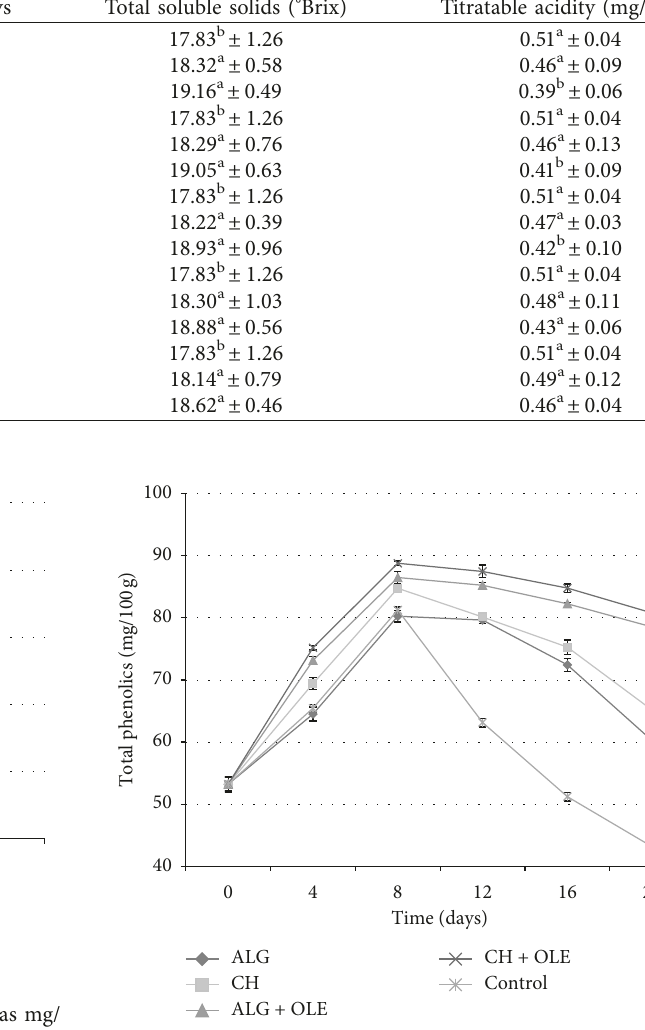
Figure 2: Total phenolic content during storage expressed as mg of gallic acid equivalent per 100g fresh weight of the sample. ALG: 3% alginate, CH: 1% chitosan, ALG +OLE: 3% alginate +1% olive leaves extract (OLE), CH +OLE: 1% chitosan+1% OLE, and control: distilled